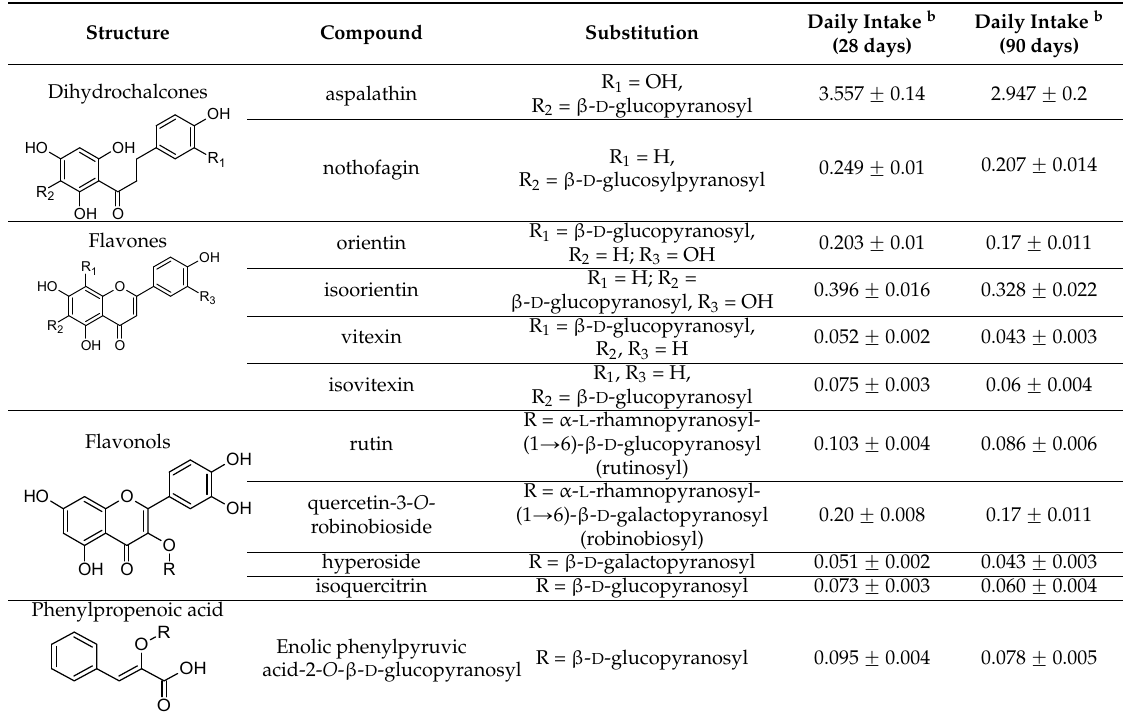
and feed intake (Table 1) and expressed as mg compound/100 g body weight. Abbreviations: GRE, green rooibos extract; TP, total polyphenol.